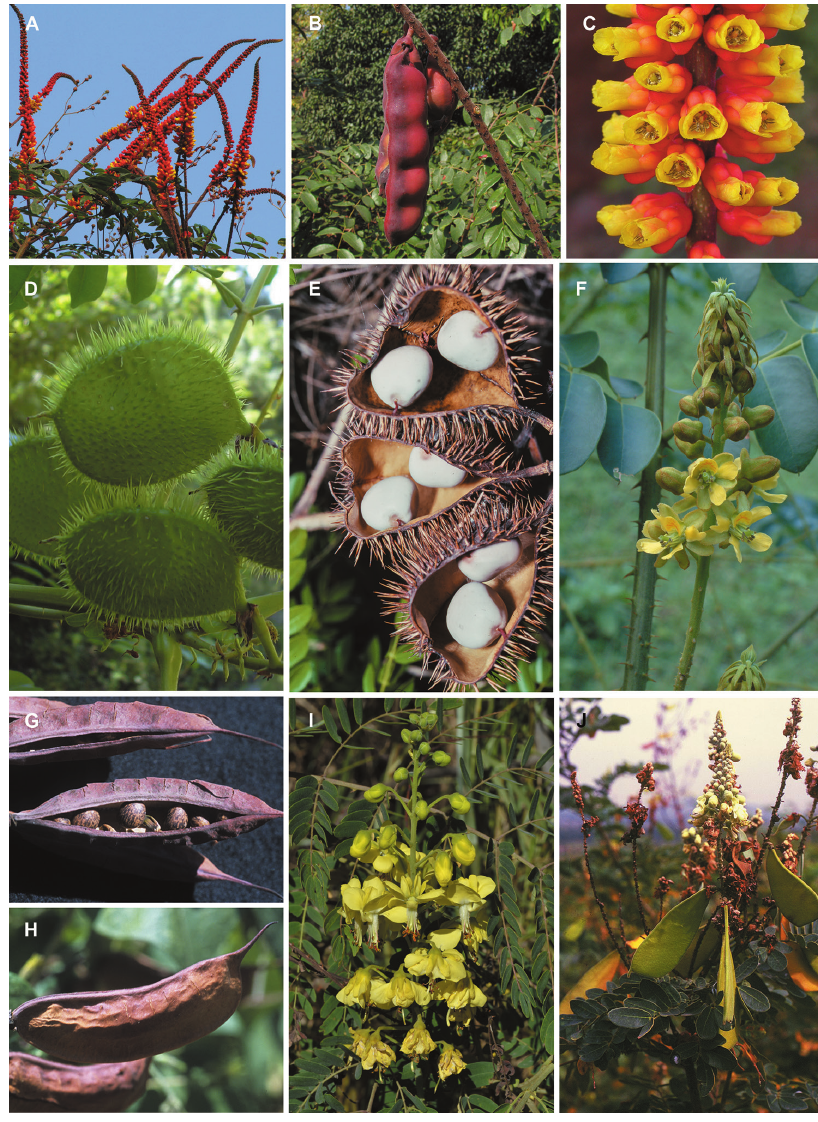
Figure 20. Moullava spicata (Dalzell) Nicolson. A inflorescences B fruit (P. Awale, Flowers of India (http://www.flowersofindia.net/), Maharashtra, India, unvouchered ) C flowers (M. Sanjappa, India, un- vouchered ). Guilandina bonduc L. D young fruits (F. Starr and K. Starr, Starr Environmental (http://www. starrenvironmental.com/images/species/?q=Caesalpinia+bonduc), Florida, USA, unvouchered) E fruits with mature seeds (G. P. Lewis, Madagascar, Du Puy et al. M665 (K)) F inflorescence (M. Sanjappa, India, unvouchered ). Biancaea decapetala (Roth) O. Deg. G fruits with seeds H fruit with thickened su- ture (C. E. Hughes, Ancash, Peru, Hughes et al. 2227 (FHO)) I inflorescence (E. Gagnon, Ancash, Peru, Hughes et al. 3055 (MT)). Biancaea godefroyana (Kuntze) Molinari, Mayta & Sánchez Och. J inflores- cences and fruits (F. Xaver, Wikicommons (https://commons.wikimedia.org/wiki/File:Caesalpinia_go- defroyana_1.jpg), Cambodia, unvouchered